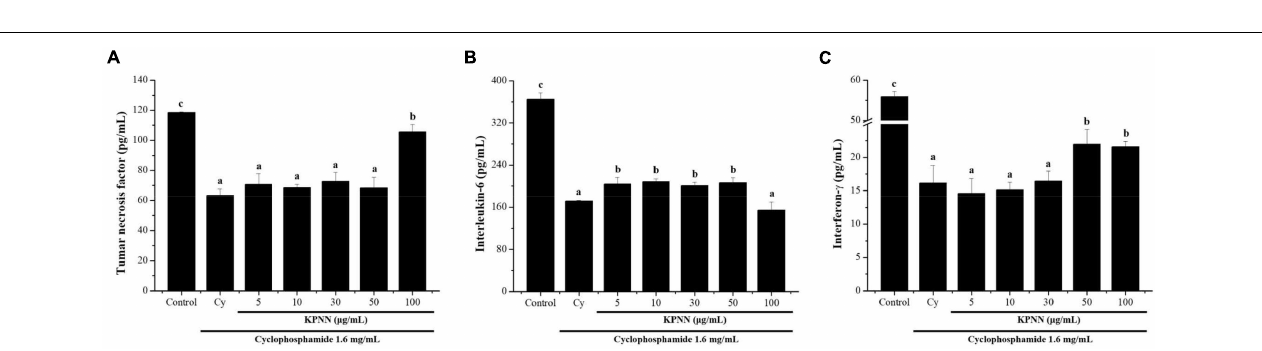
FIGURE 5 | Effects of KPNN on cytokine expression in Cy-treated splenocytes. To analyze the cytokine levels, splenocytes were seeded into a 96-well plate after incubation with Cy (1.6 mg/ml) and KPNN (0, 5, 10, 30, 50, 100 µ g/ml) for 24 h in a 5% CO 2 atmosphere. After 24 h, (A) TNF- α , (B) IL-6, and (C) IFN- γ levels in the culture media were assayed using cytokine activation analysis kits. Data are reported as the mean ± SEM ( n = 3). p < 0.05 vs. control. Bars labeled with different superscript numerals indicate p < 0.05.